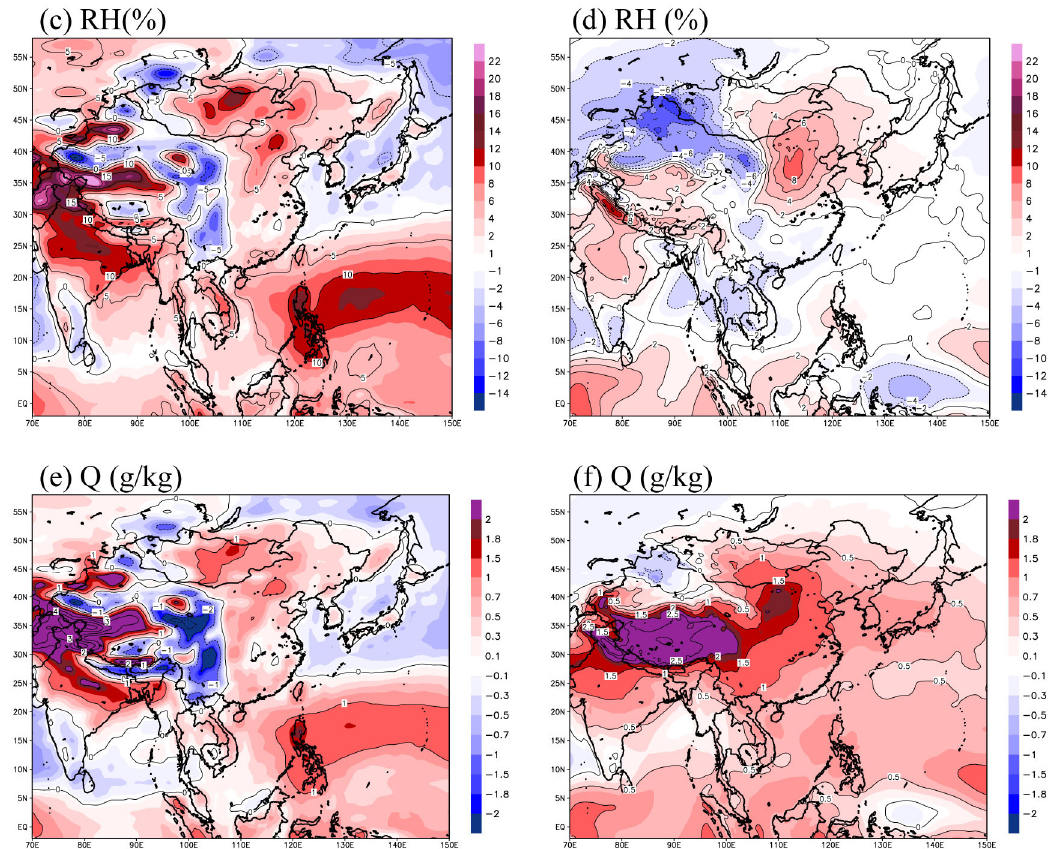
Figure 3. Spatial distribution of 20-year summer mean differences for ( a , b ) wind field (m/s) and temperature (°C); ( c , d ) relative humidity (RH, %); and ( e , f ) mixing ratio (Q, g/kg) at 850 hPa between the two BCs (ERA, R2) ( left ) and between the two simulations (ERA_ReC, R2_ReC) forced by the ERA and R2 datasets ( right